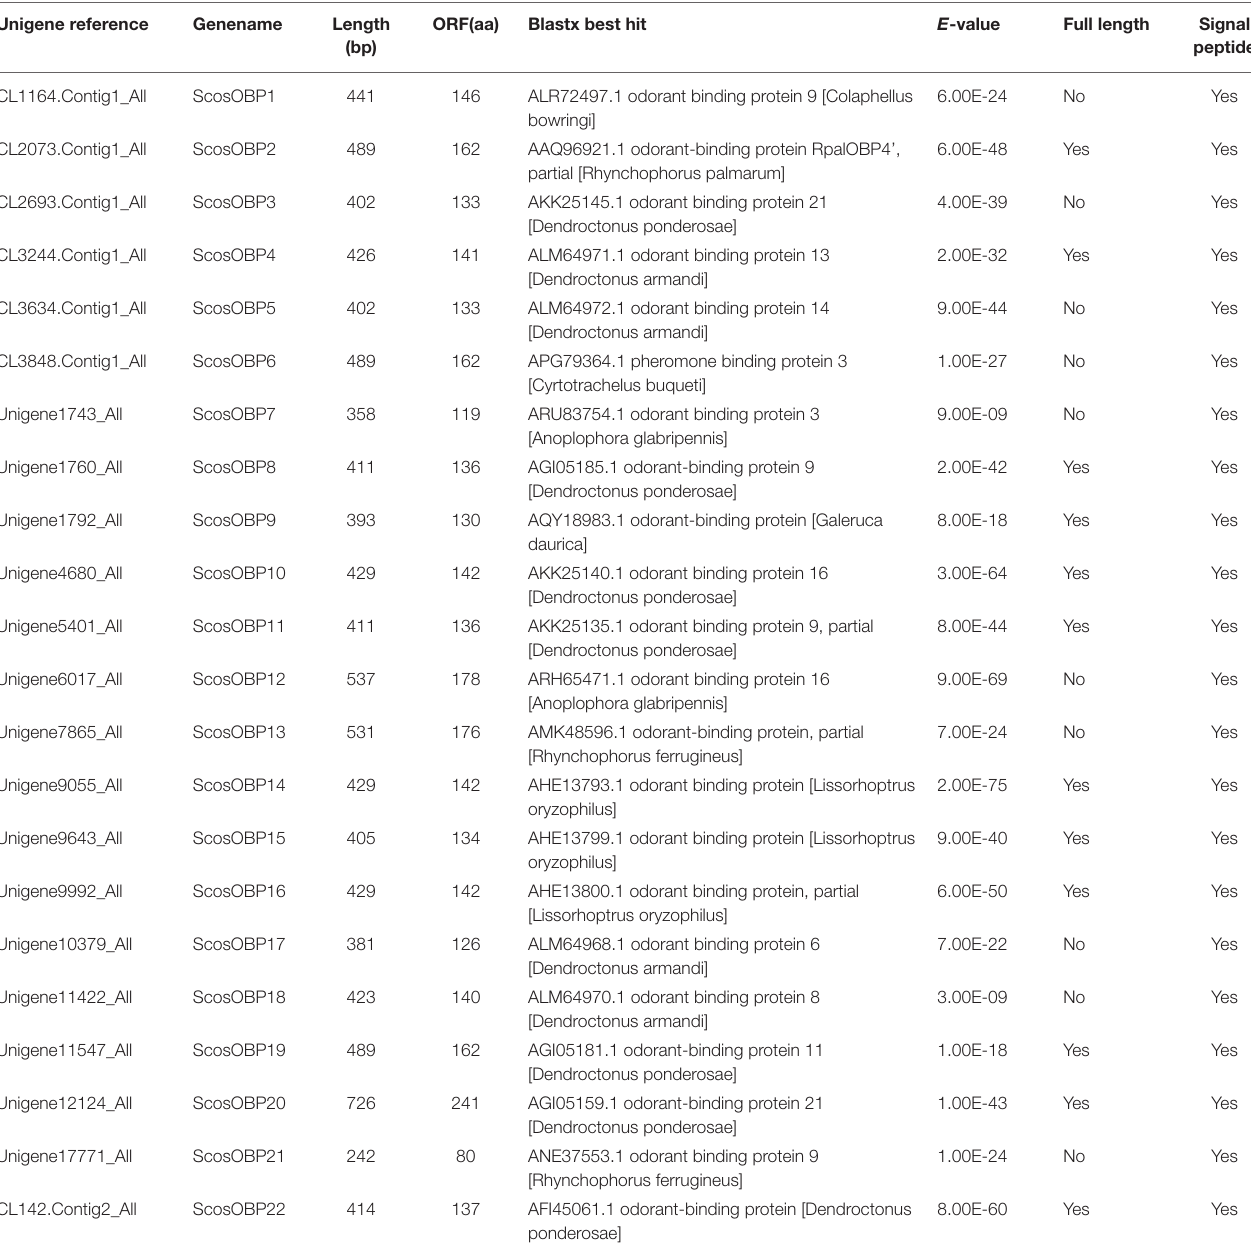
TABLE 3 | Unigene of candidate odorant binding proteins. Unigene reference Genename Length ORF(aa) Blastx best hit E -value Full length Signal (bp)